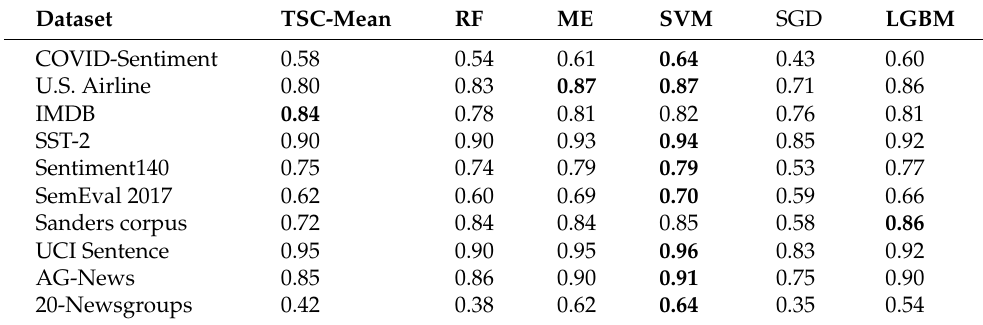
Table 10. SBERT vector-based AUC-PRC score for six classifiers. Best results are in bold face. Dataset